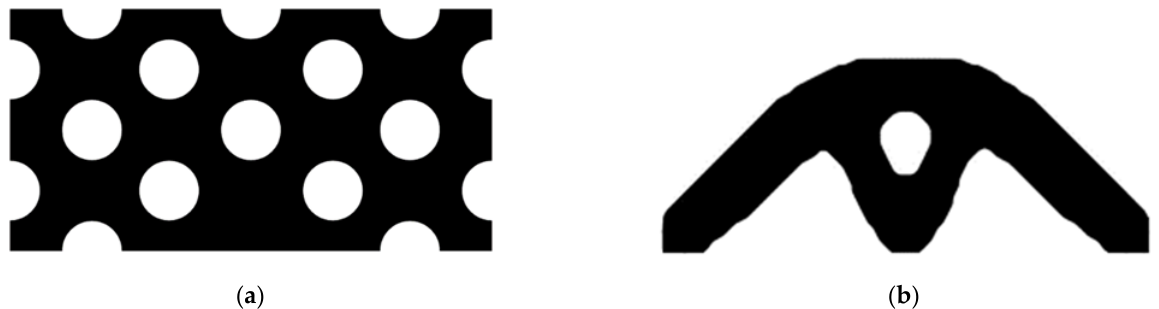
Figure 15. Optimal design problem of simple bridge beam by classical level set topology optimization, ( a ) initial shape; ( b ) optimized shape.